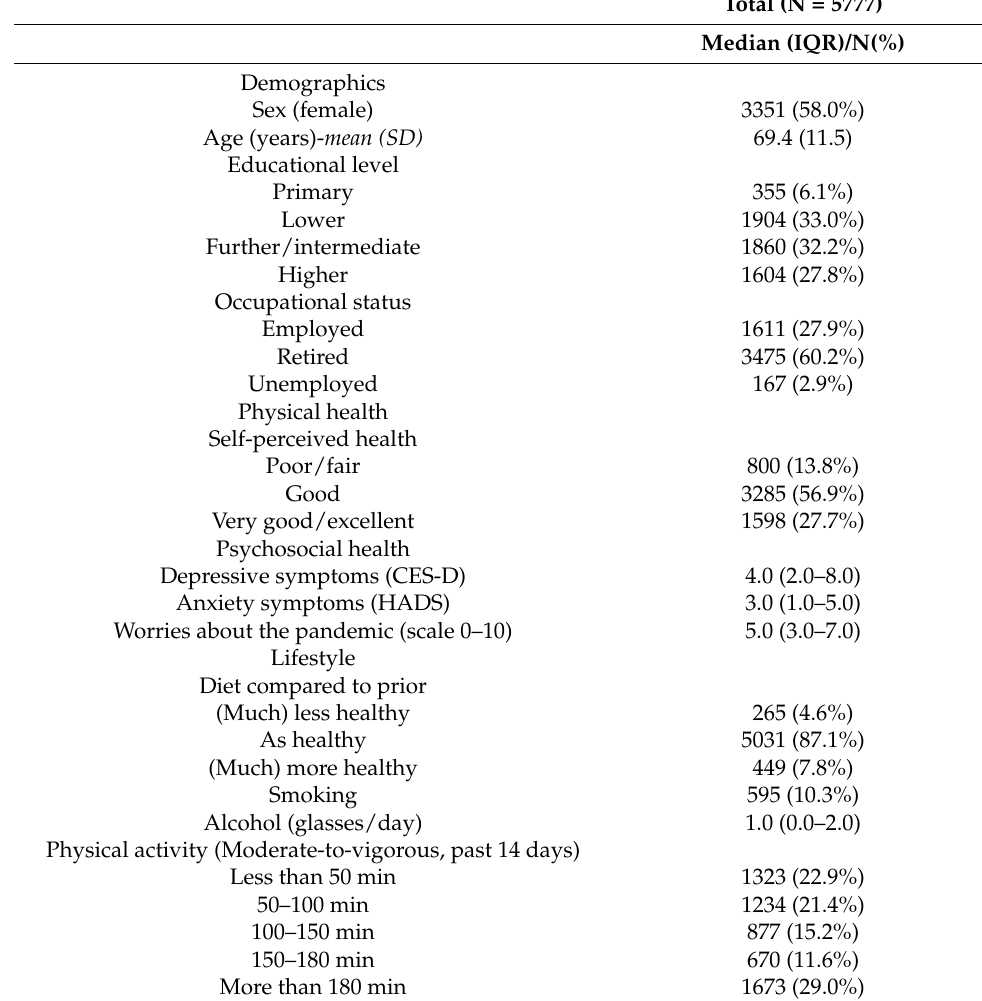
Table 1. Study sample